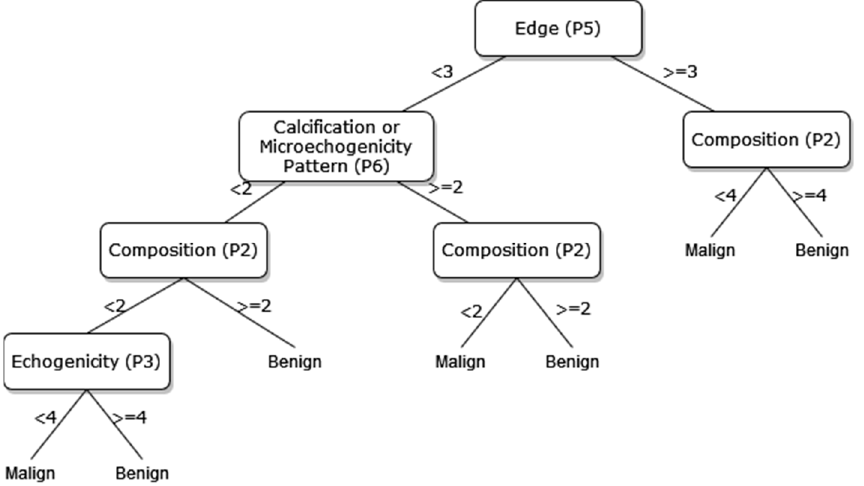
Figure 10. The pruned decision tree of 8 sonographic signs.